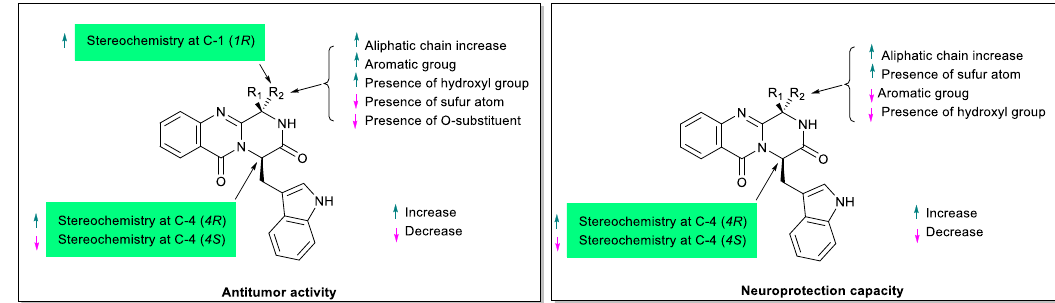
Figure 4. Structure-activity relationship studies of quinazolinone alkaloids 1 – 12 with antitumor and neuroprotective